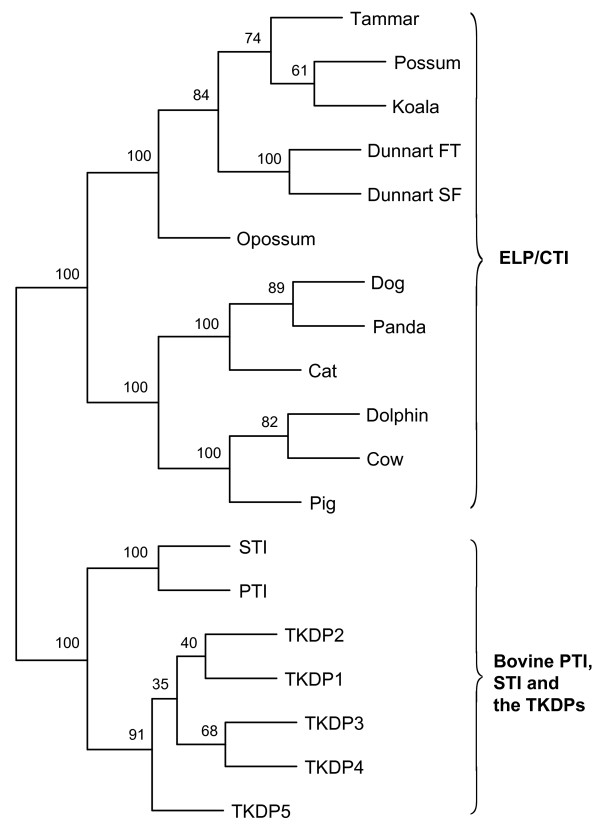
A phylogenetic tree ofELP/CTIand theCTI-like bovinePTI,STIandTKDP1,2,3,4and5family. The evolutionary relationship between the protein-coding regions of the marsupial ELP, eutherian CTI and bovine TKDP1-5, PTI and STI transcripts was determined by maximum likelihood analysis using a molecular clock assumption. The bovine SLPI transcript was used as an outgroup (data not shown). Two main groups were formed: 1. mammalian ELP/CTI and 2. bovine CTI, PTI and the TKDPs. Numbers at branch points indicate confidence levels as determined by bootstrap values (100 replicates). Phylogenetic trees were produced with Phylip software version 3.69. Transcripts were aligned with MUSCLE and boostrapped values generated with SEQBOOT. Maximum likelihood trees were generated with DNAMLK using a transition/transversion ratio of 1.34, a Gamma distribution shape of 1.39 with 5 Hidden Markov Model categories, global rearrangements and with a randomised input order jumbled once. The protein-coding regions of the following transcripts were used in the analysis: ELP/CTI, tammar [GenBank: JN191338], fat-tailed dunnart [GenBank: JN191339], stripe-faced dunnart [GenBank: AC186006], koala [GenBank: JN191337] opossum [GenBank: JN191340], brushtail possum, cow [GenBank: JN191341], dog [GenBank: JN191342], cat [GenBank: BK008083], pig [Ensembl: F1SD34_PIG (ENSSSCT00000008098)], Giant panda [GenBank: BK008084], and Common bottlenose dolphin [GenBank: BK008086], and the following bovine transcripts: PTI [GenBank: NM_001001554], STI [GenBank: NM_205786], TKDP1 [GenBank: NM_205776], TKDP2 [GenBank: NM_001012683], TKDP3 [GenBank: XM_584746], TKDP4 [GenBank: NM_205775], and TKDP5 [GenBank: XM_614808] and SLPI [GenBank: NM_001098865].